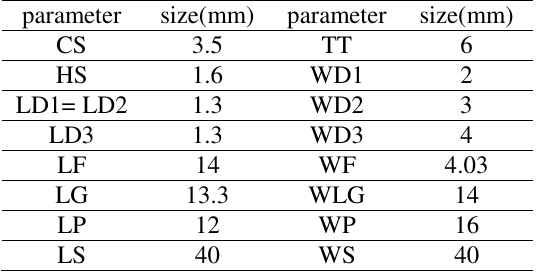
Table 1: Optimized parameters for basic hammer-shaped